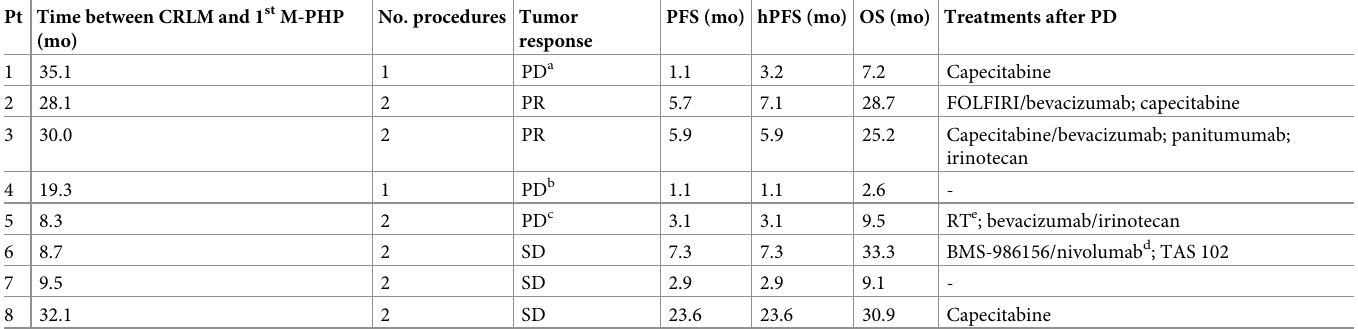
Table 3. Tumor response and